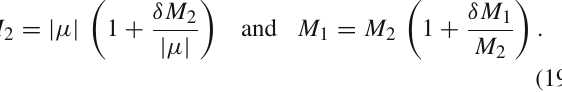
Fig. 1 Variation of the neutralino and chargino mass spectra for sce- narios featuring μ > 0, as a function of | μ | (upper left), tan β (upper right), δ M 2 / | μ | (lower left) and δ M 1 / M 2 (lower right) when all other parameters are fixed to their reference value given in Eq. (20). The